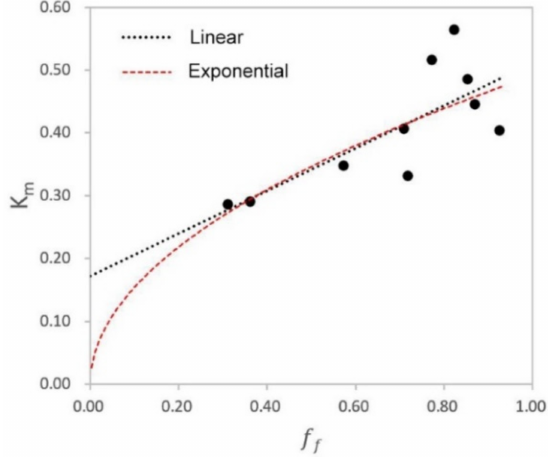
Figure 5. Linear and exponential correlations of light extinction coefficient (k m ), which were calcu- lated from true LAI values, and fraction of foliage cover ( f f ).